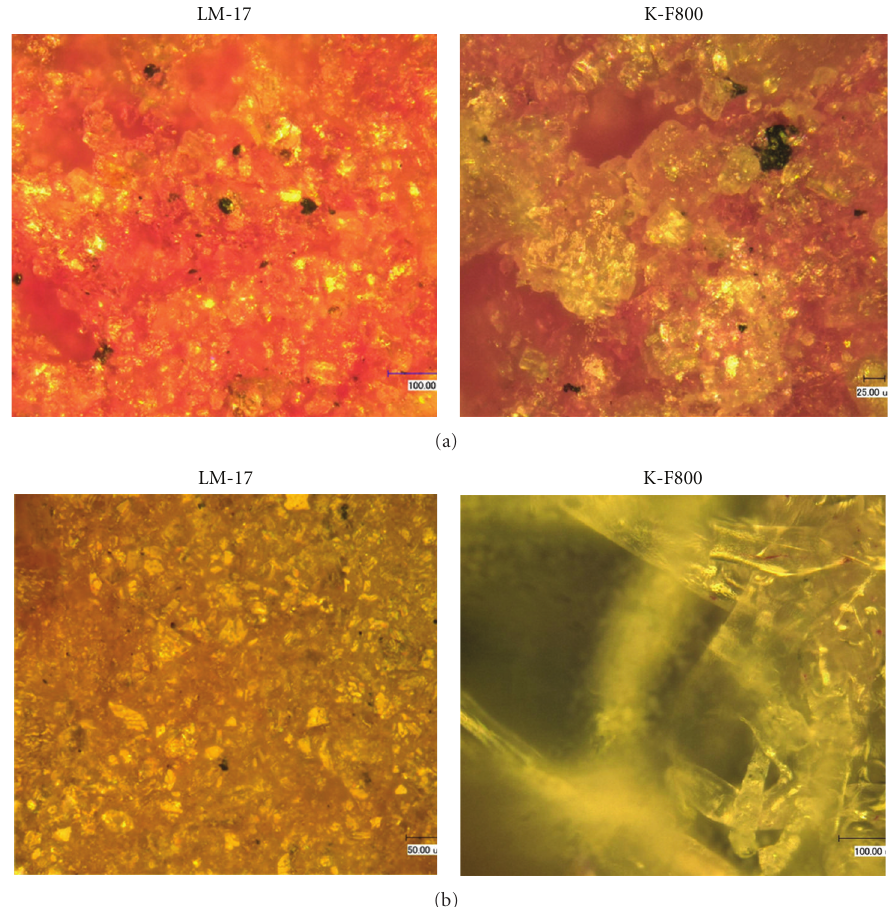
Figure 6: Mock PBX created by (a) amination and (b) precision